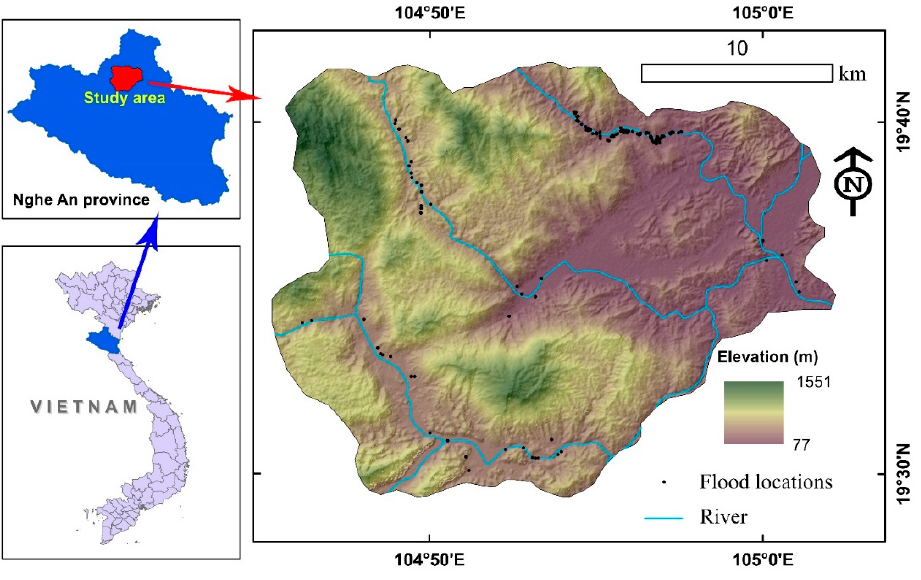
Figure 1. Location of the study area and flash floods.